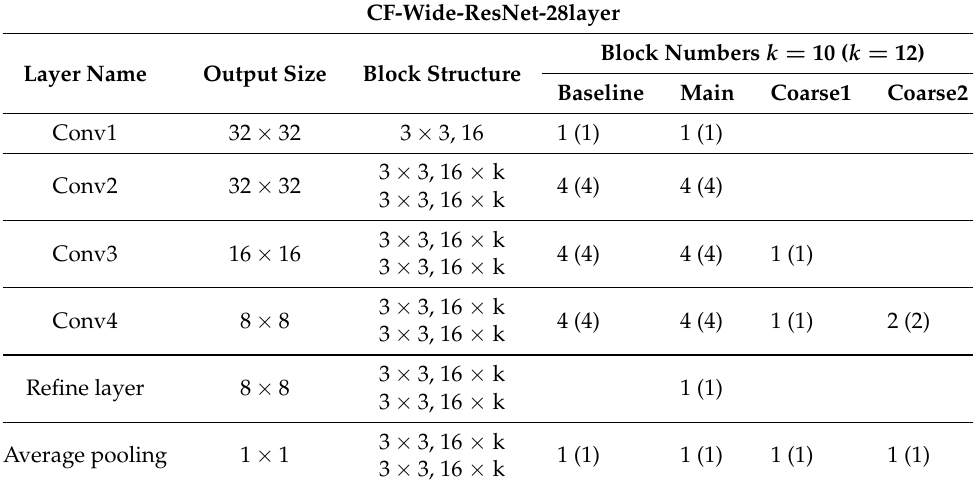
Table 4. Structure of the CF-Wide-ResNet-28layer model for CIFAR-10 and CIFAR-100